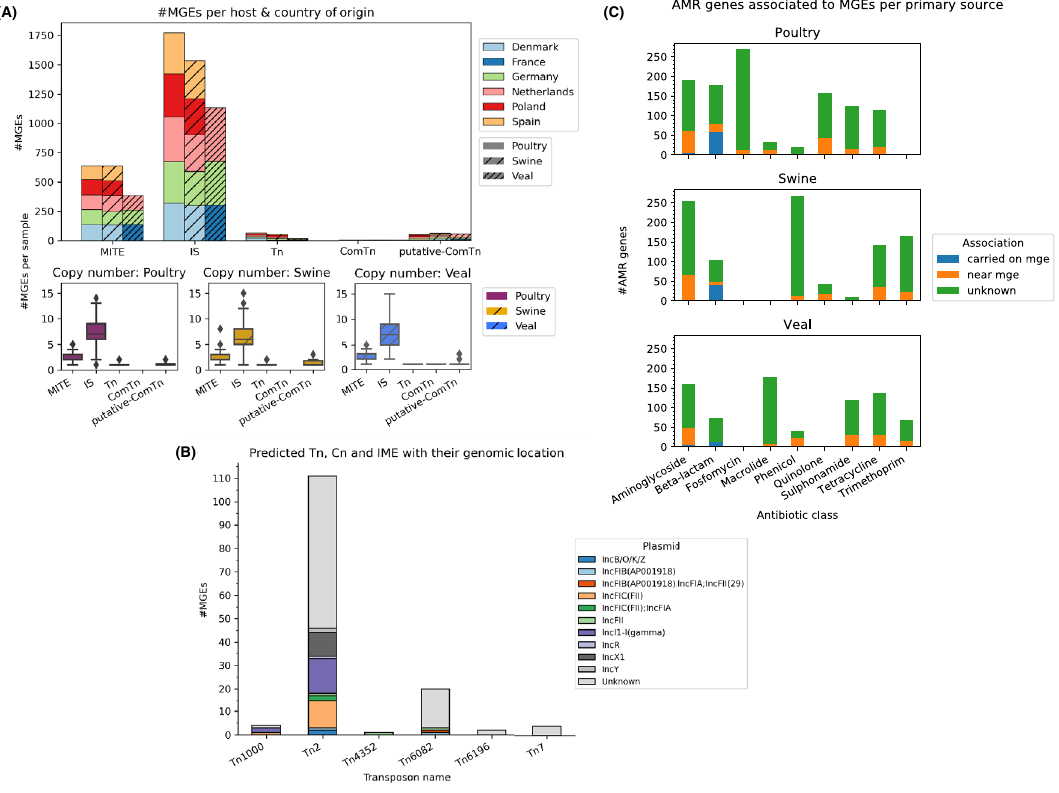
Figure 5. ( A ) Distribution of mobile genetic elements (MGEs) in E. coli isolates per animal host and country of origin (top). Distribution of MGEs per E. coli isolate in different animal hosts (bottom). Cn XX, IS insertion sequences, MITE miniature inverted-repeat transposable elements, and Tn transposons. ( B ) Distribution of transposons and their plasmids. ( C ) Number of MGEs associated with mobile elements per antimicrobial class and animal source. There are three levels of associations, carried on MGEs, if MGE is located within 31 kbp from an AMR and unknown